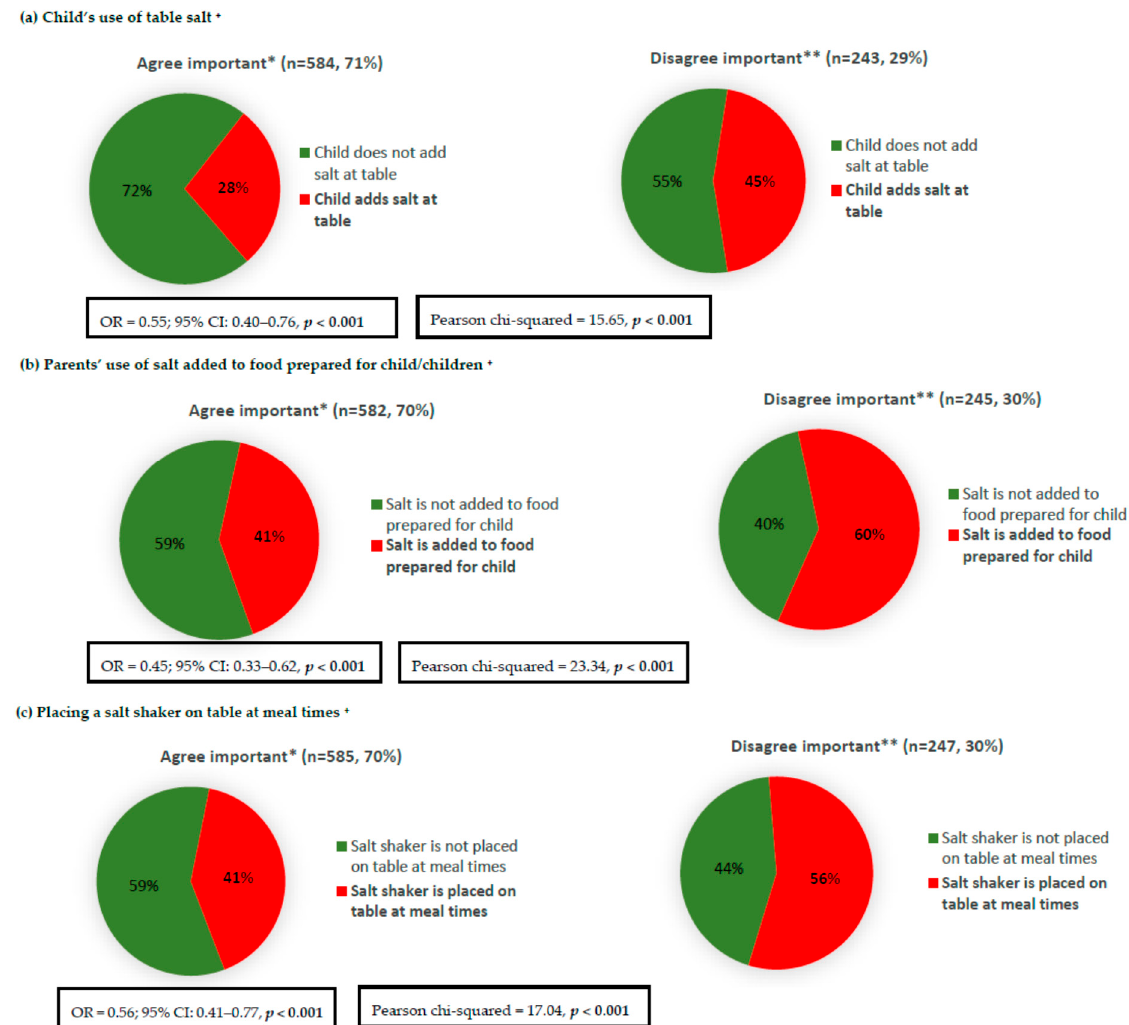
Figure 5. Association between parents’ attitude towards the importance of limiting the amount of salt their child eats and discretionary salt use behaviours related to their child/children. * Figure 5 responses include ‘strongly agree’ and ‘agree’; ** Figure 5 responses include ‘strongly disagree’, ‘disagree’ and ‘neither agree nor disagree’; + Logistic regression adjusted for parent’s age, sex, and SES.